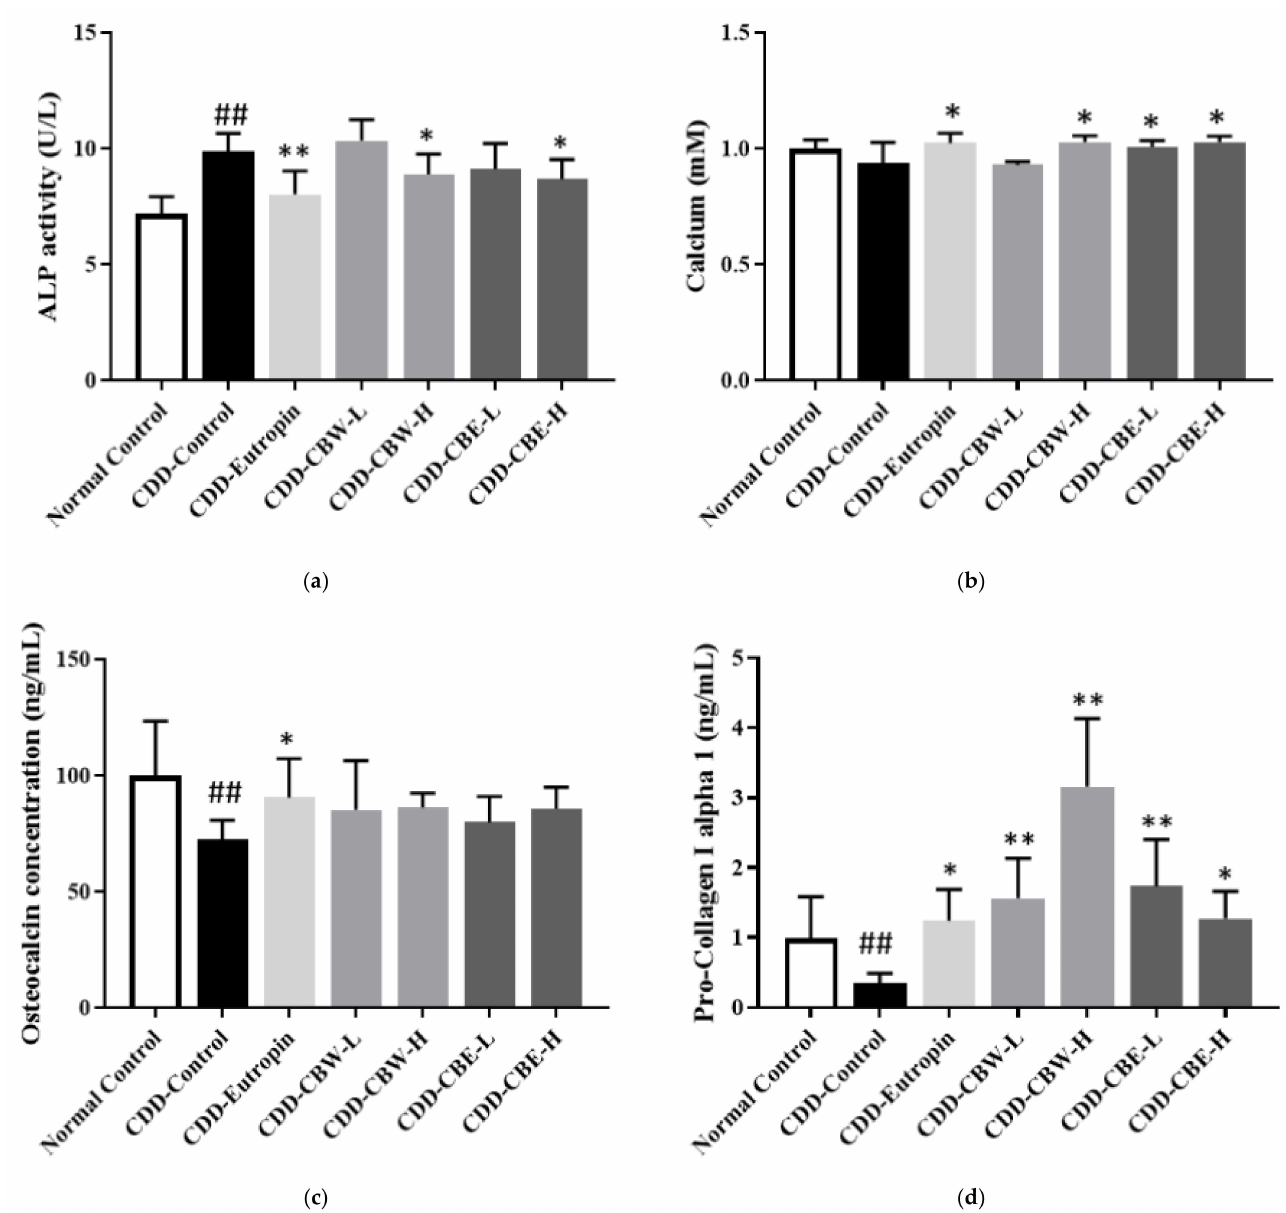
Figure 4. The serum alkaline phosphatase (ALP) activity, calcium, osteocalcin (OC), and pro-collagen I alpha 1 level: ( a ) 1/10 serum ALP, ( b ) 1/20 serum calcium, ( c ) 1/20 serum OC concentration, and ( d ) 1/100 serum pro-collagen I alpha 1. All data are presented as the mean ± SD ( n = 8 per group). ## p < 0.001 compared with the normal control group, * p < 0.05, and ** p < 0.01 compared with the CDD-control